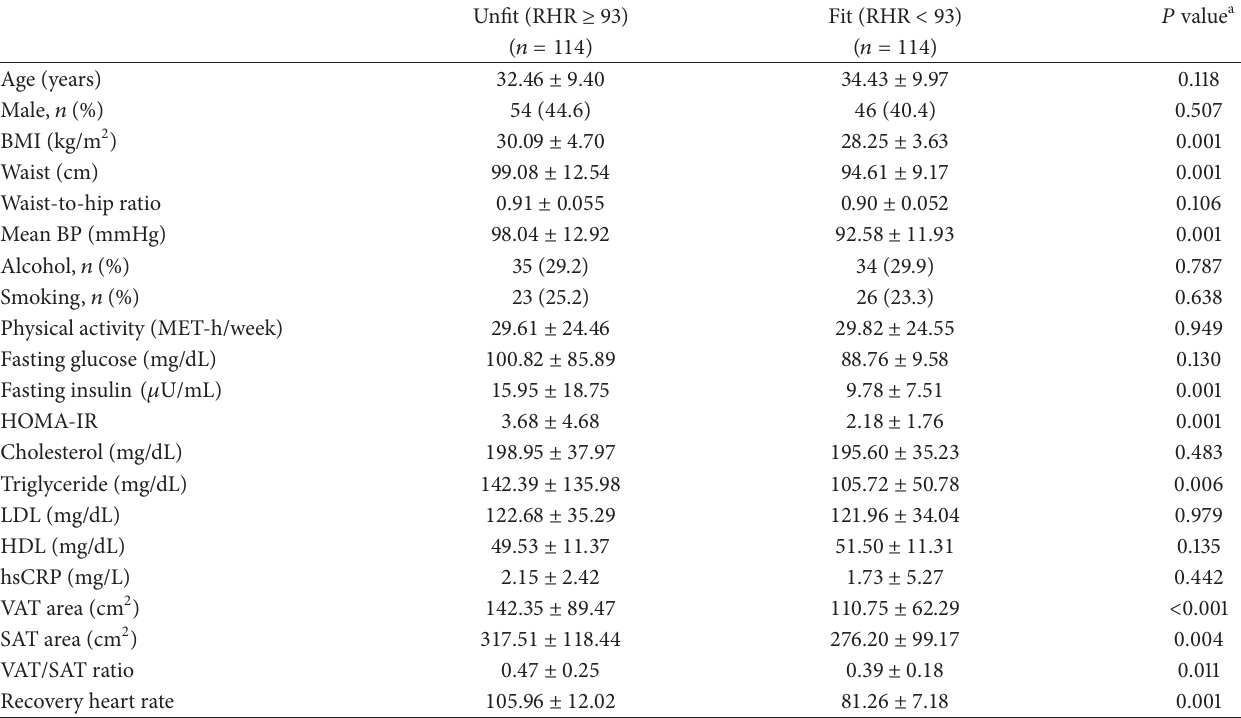
Table 1: Clinical characteristics of the study participants according to fitness level (recovery heart rate).